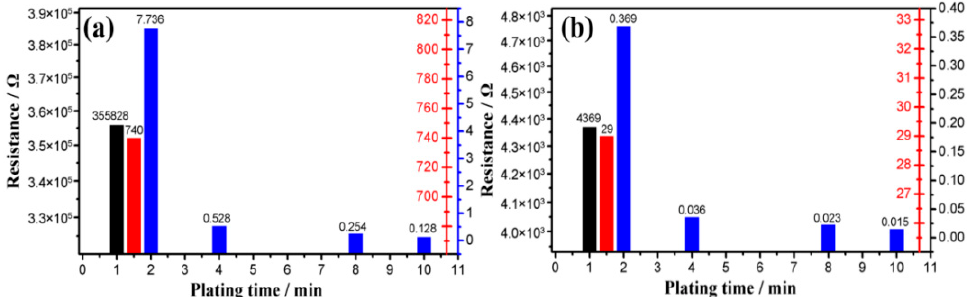
Figure 9. The resistance of sponge with different plating times: ( a ) before compression and ( b ) after compression.